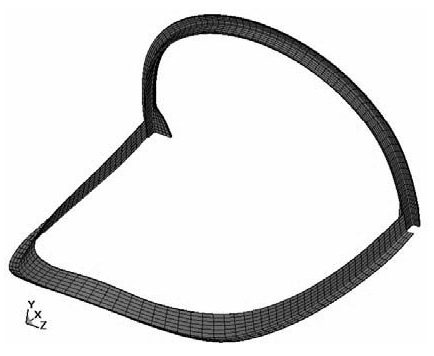
Fig. 5. FE model of framework and arc-frame.